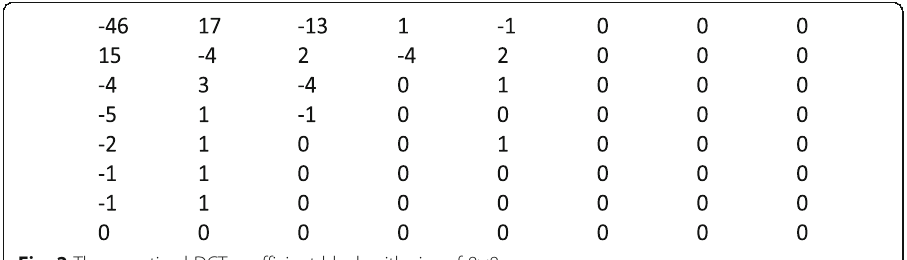
Fig. 2 The quantized DCT coefficient block with size of 8×8